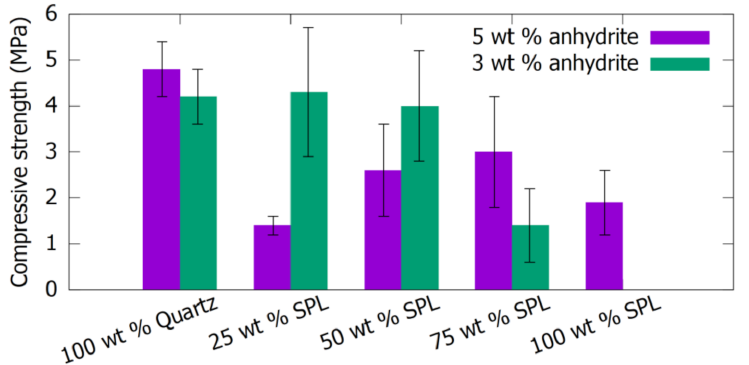
Figure 12. Compressive strength of the AAC blocks using several replacement levels of quartz for SPL aluminosilicates.